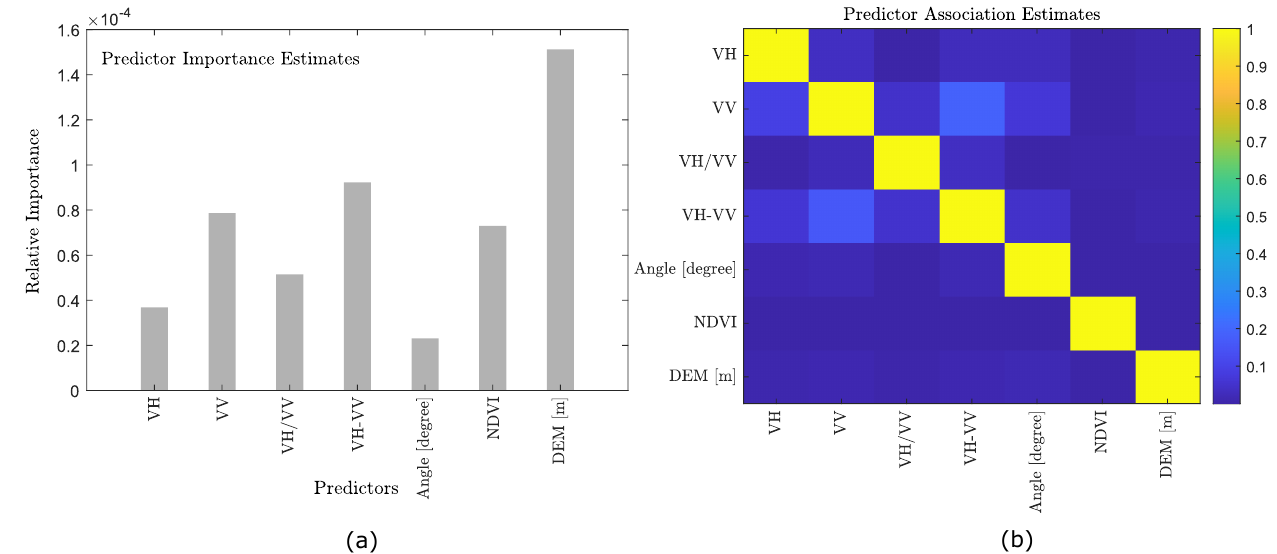
Figure 8. ( a ) Bar plot illustrates the relative feature importance score of the input features, ( b ) feature association